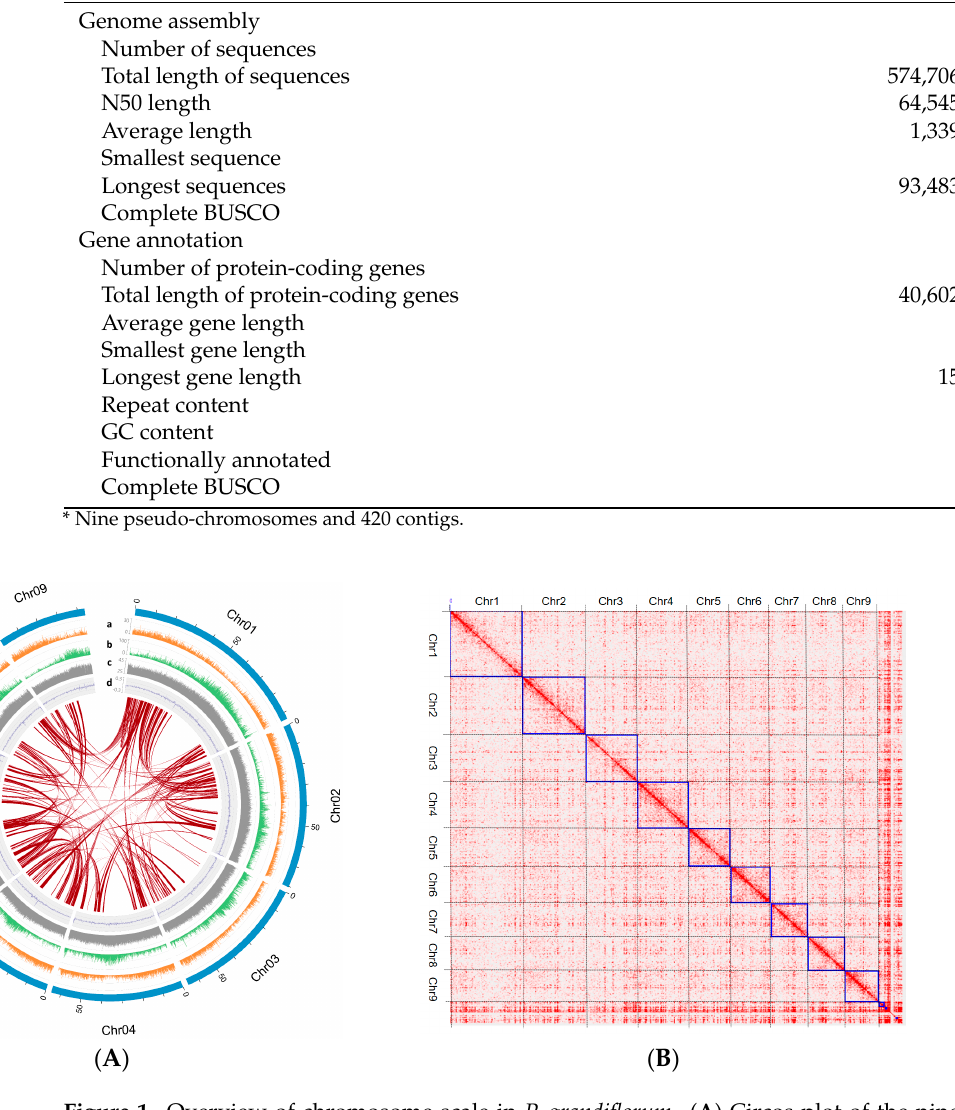
Figure 1. Overview of chromosome scale in P. grandiflorum . ( A ) Circos plot of the nine pseudo-chromosomes. The outermost track (light blue) indicates nine pseudo-chromosomes. The a–d track shows the distribution of genes (a, orange), repeat distribution (b, green), GC contents (c, gray), and GC skew (d, blue) in non-overlapping 100 kb sliding windows. The innermost lines (red) indicate collinear blocks identified within the pseudo-chromosomes. ( B ) Heatmap of Hi-C assisted assembly. Blue box indicates higher contact